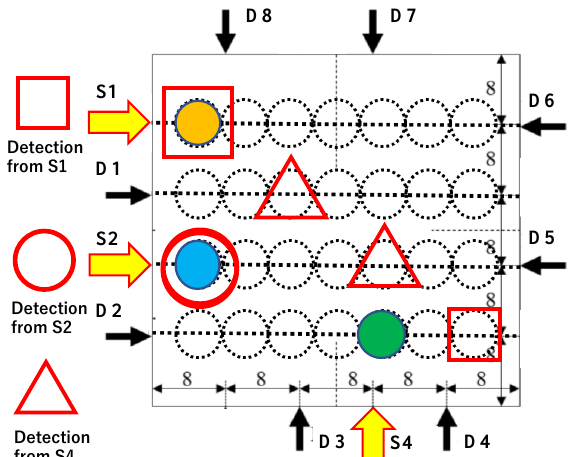
Figure 11. Example for a multi-beam injection model. three absorbers, and three different incident beams. Each symbol corresponds to detected positions for each